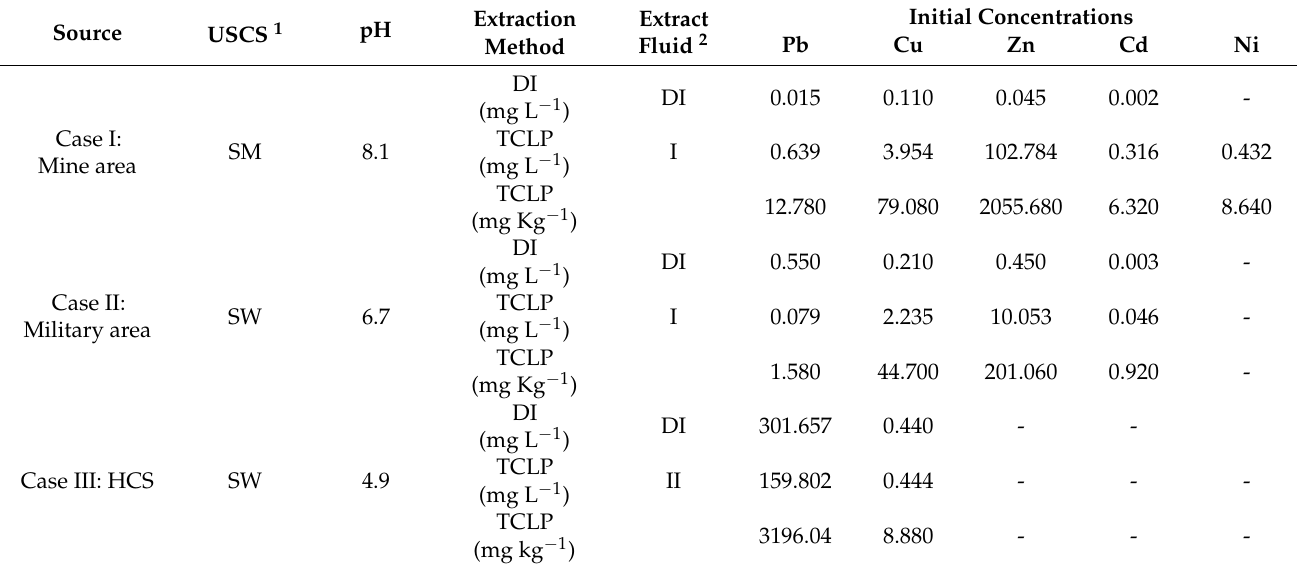
Table 1. Physiochemical properties of silty sand soil, sandy soil and handmade HCS; toxic metal concentrations in leachates before binder